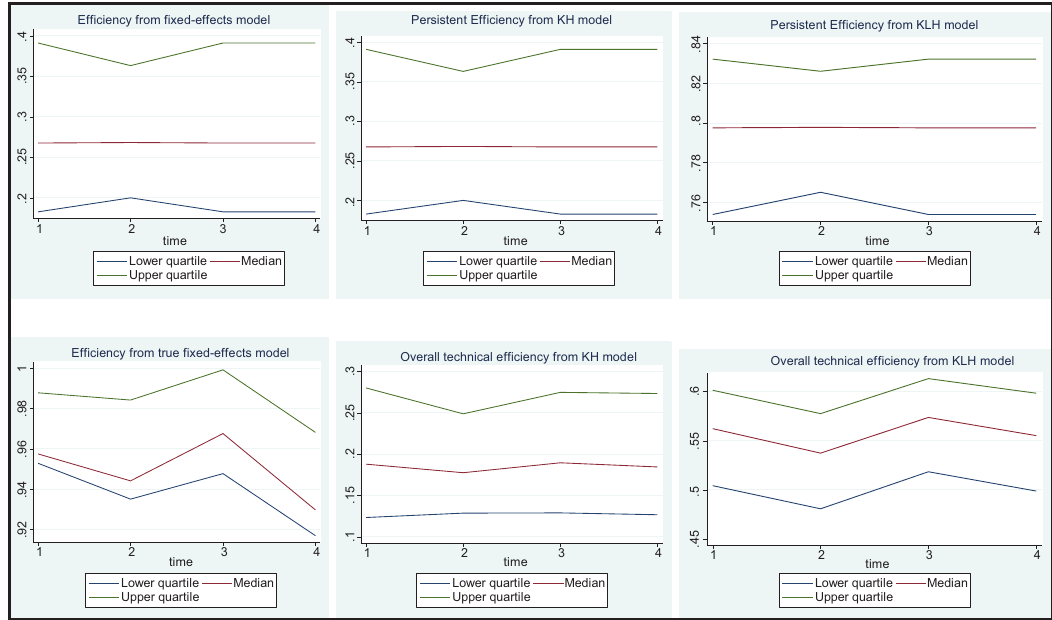
Figure 3 The median, first, and third quartiles (middle, bottom, and top lines) of persistent and OTE in the TFE, KH, and KLH